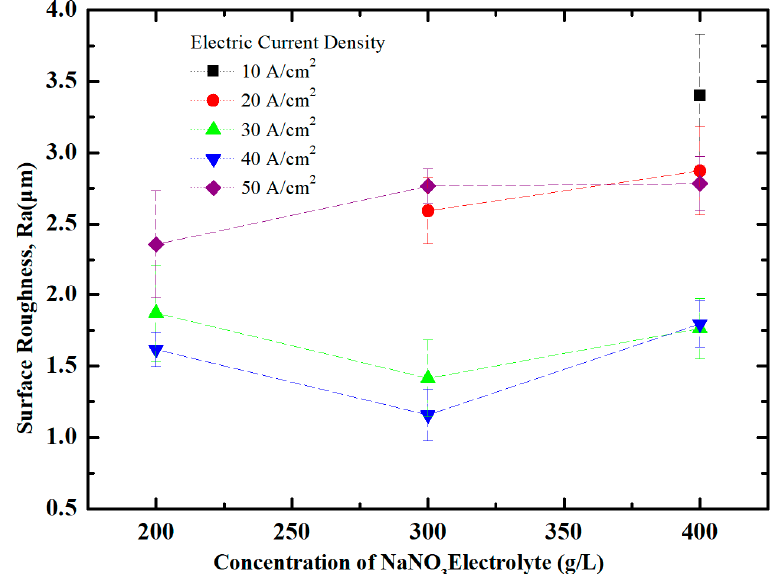
Figure 15. Surface roughness of workpiece at different concentration in NaNO 3 electrolyte.